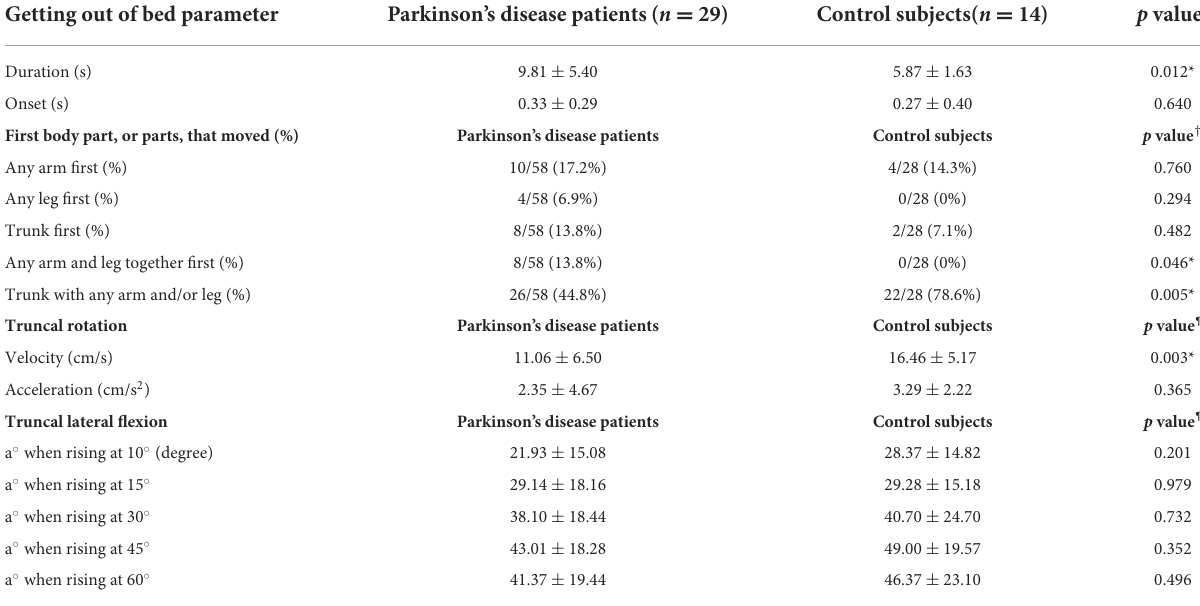
TABLE 2 Comparison of getting out of bed parameters between patients with Parkinson’s disease and control subjects. Getting out of bed